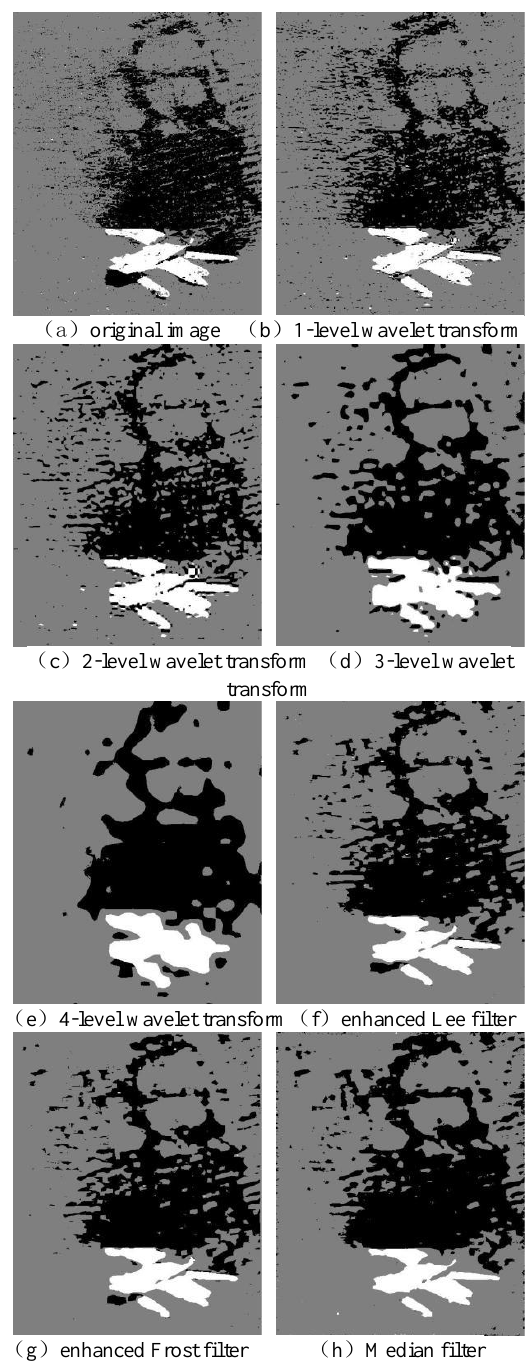
Figure 4. SVM detection results of different sun glint suppression method （ black is oil film, gray is seawater, and white is working ship and platform